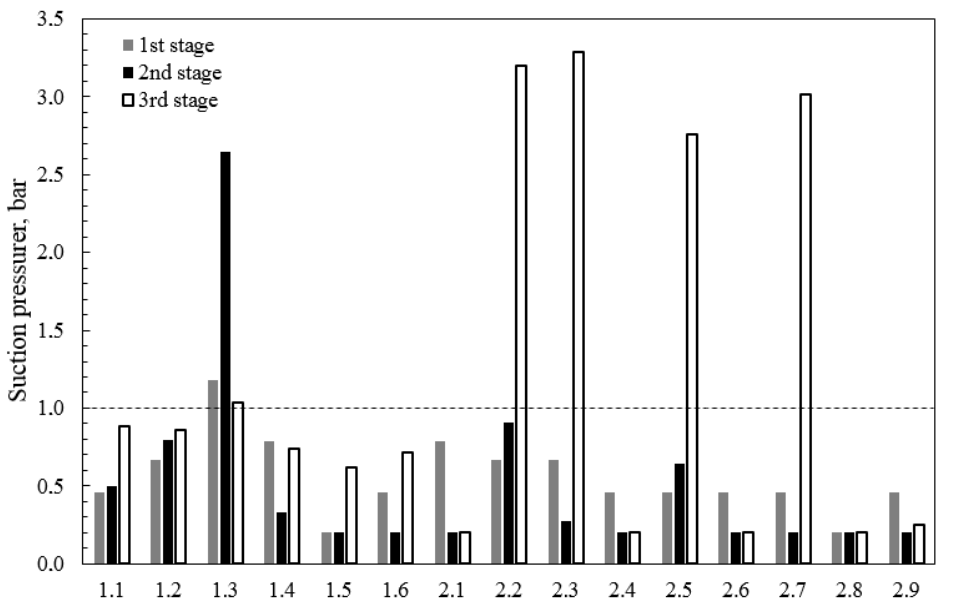
Figure 14. Suction pressures of the compressors during suction for the analyzed refrig- eran